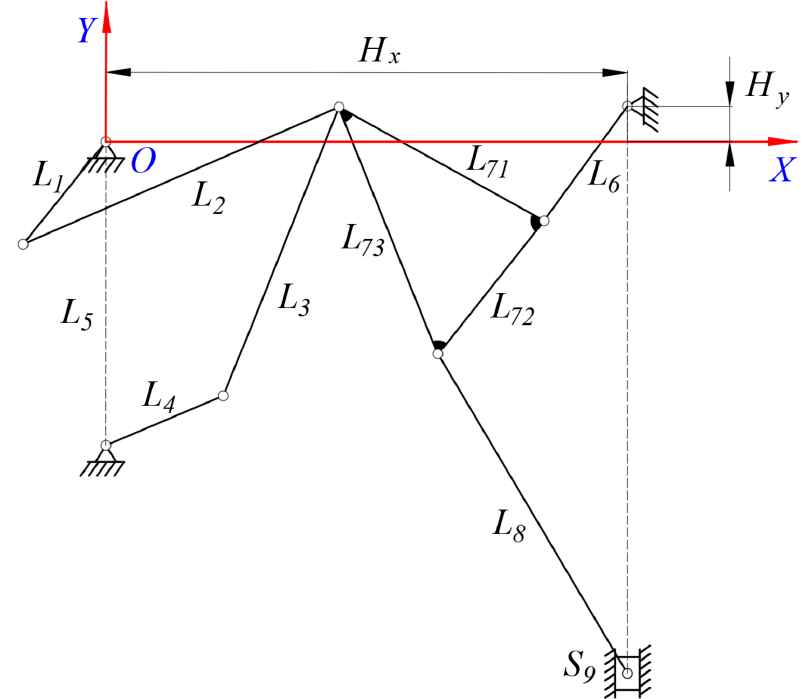
Figure 3. Diagram of a 2- DOF nine–bar mechanism.